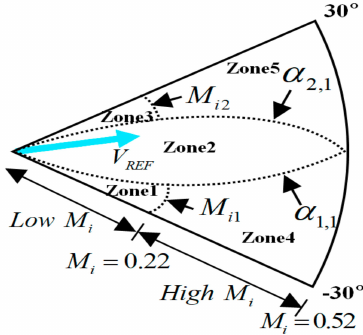
Figure 6. Definition of zone for a minimum root mean square torque ripple-remote-state pulse-width modulation